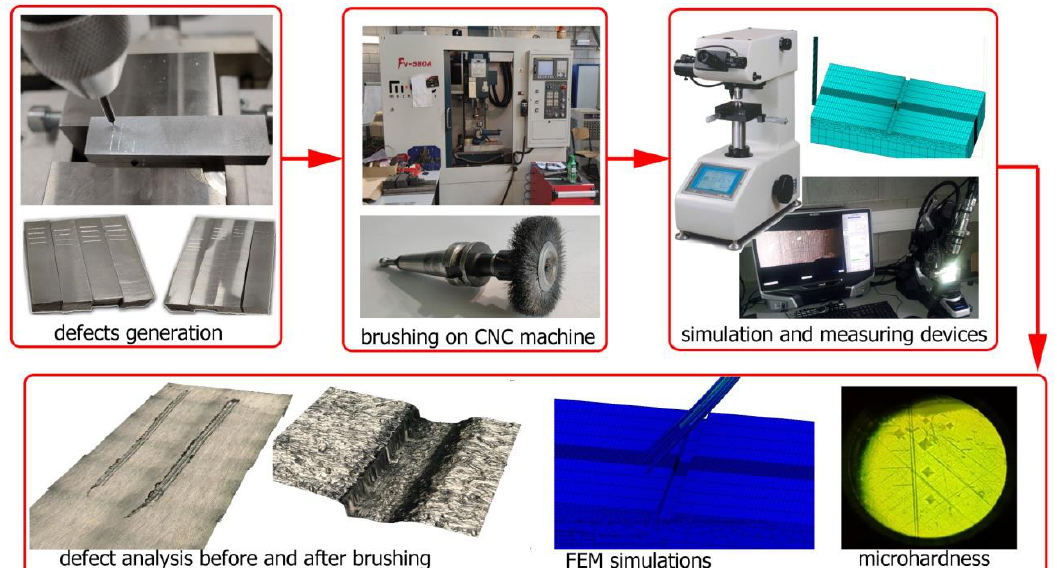
Figure 3. General diagram of the experiment methodology.